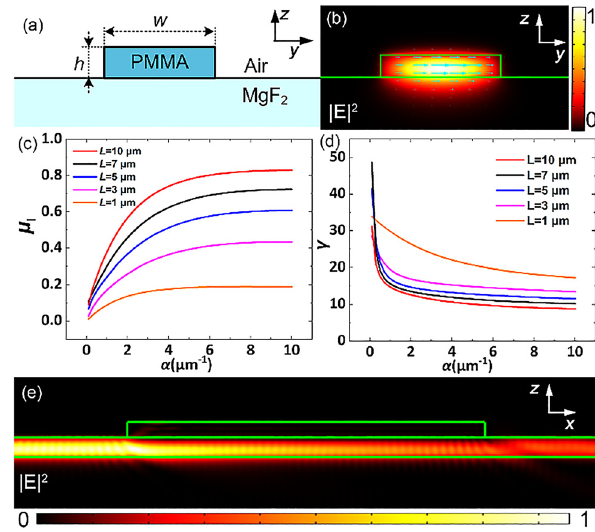
Figure 2: IPWP method. (a) Cross-section schematic of the PMMA waveguide. (b) Field distribution | E | 2 of the TE 0 waveguide mode supported by the PMMA waveguide at λ = 450 nm. (c) Relationship between the absorption ef fi ciency μ I and the absorption coef fi cient α of the gain dielectric stripwithdifferentlengths( L )intheIPWPmethod.(d)Theratioofthe absorption ef fi ciencies of the IPWP method and VP method versus the absorption coef fi cients of gain dielectric strips with different lengths of gain dielectric strips. (e) Field distribution | E | 2 at λ = 450 nm in the IPWP method with α = 3 μ m − 1 .